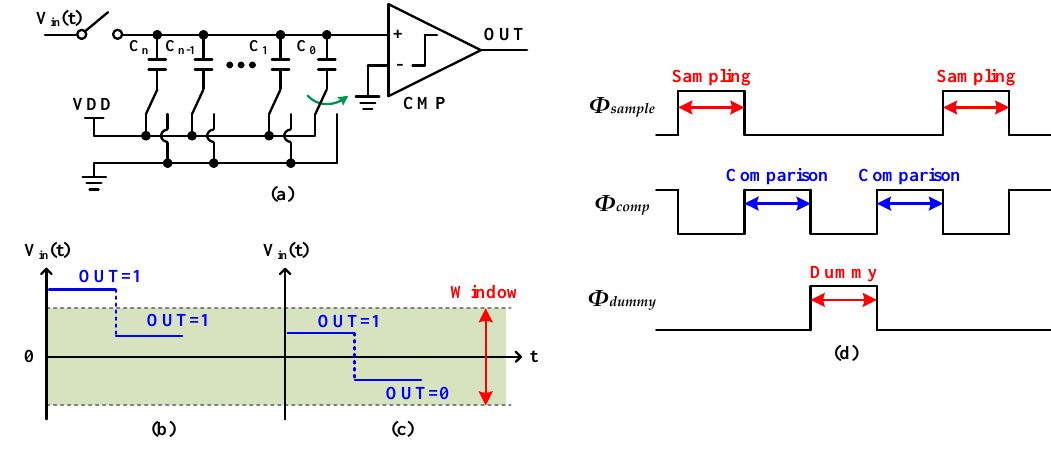
Figure 5. ( a ) Basic structure of the SAR-based window detector and its operating principle when ( b ) outside the window and ( c ) inside the window. The timing diagram is shown in ( d ).